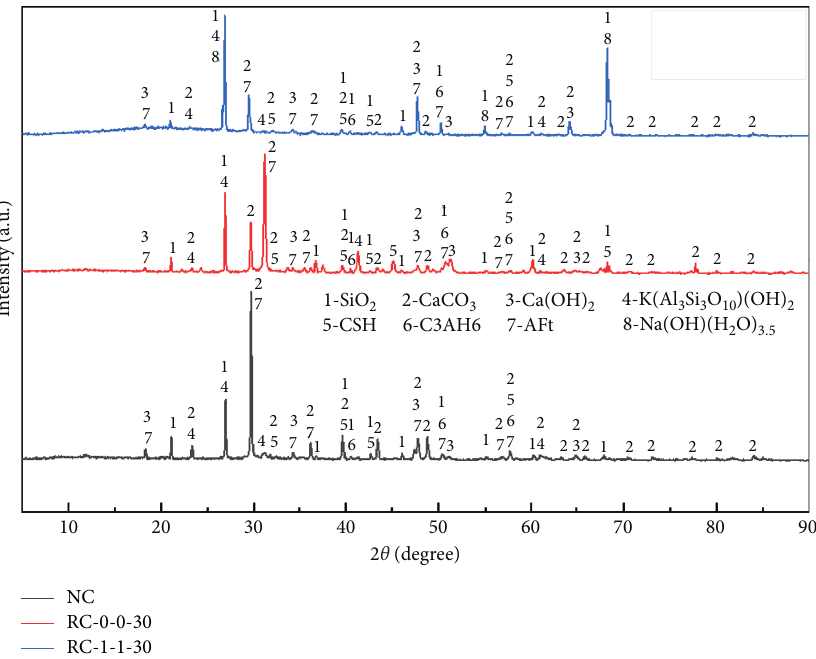
Figure 11: XRD diffraction peak